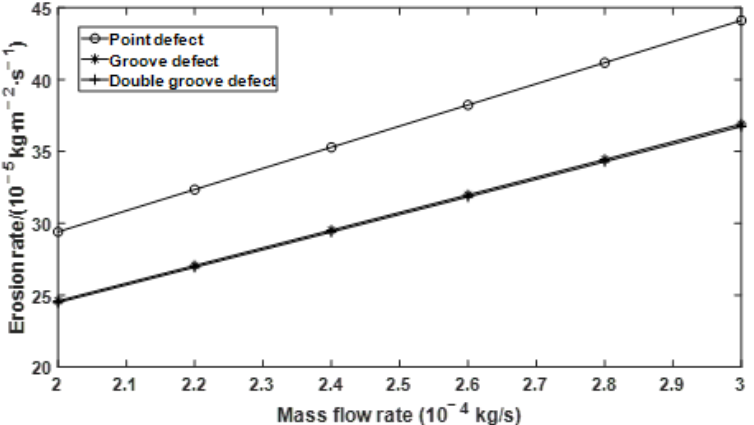
Figure 7. Effect of flow velocity on erosion rate under different defect conditions.